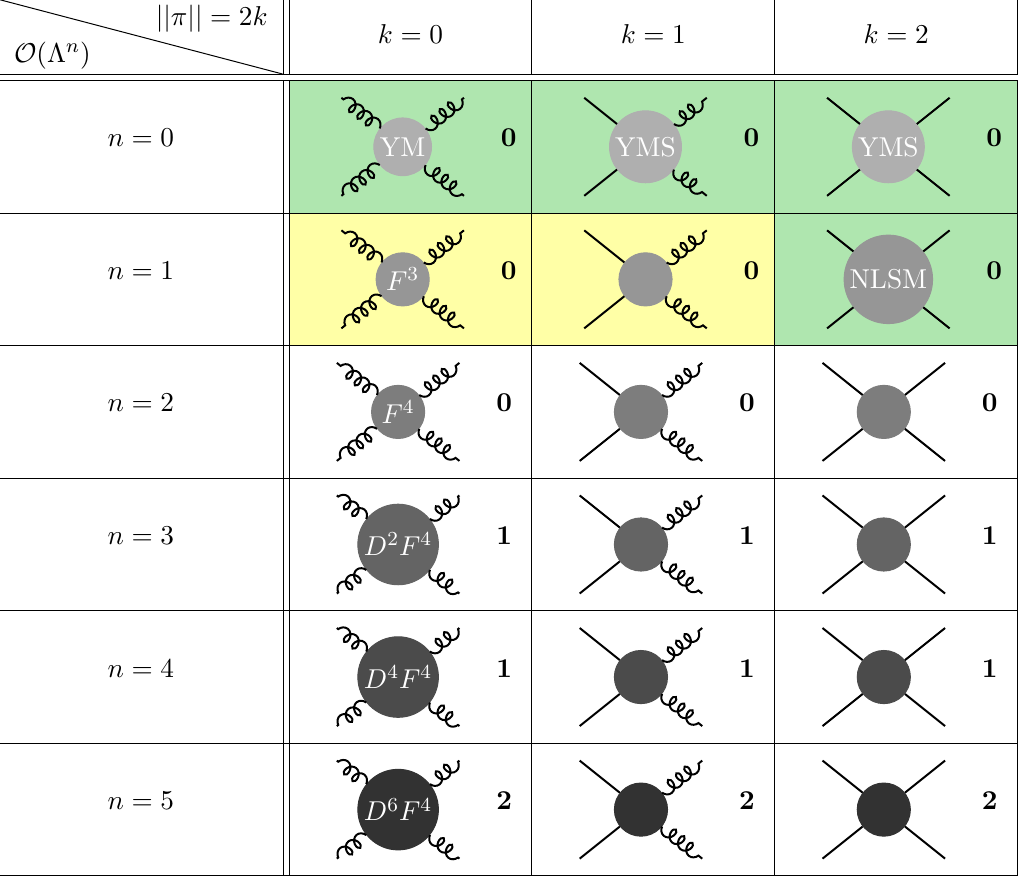
Table 2 . Four-point amplitudes for k pairs of pions — Green cells contain amplitudes generated by eq. (3.1). The additional interactions highlighted in yellow were needed in eq. (3.8) for double-copy